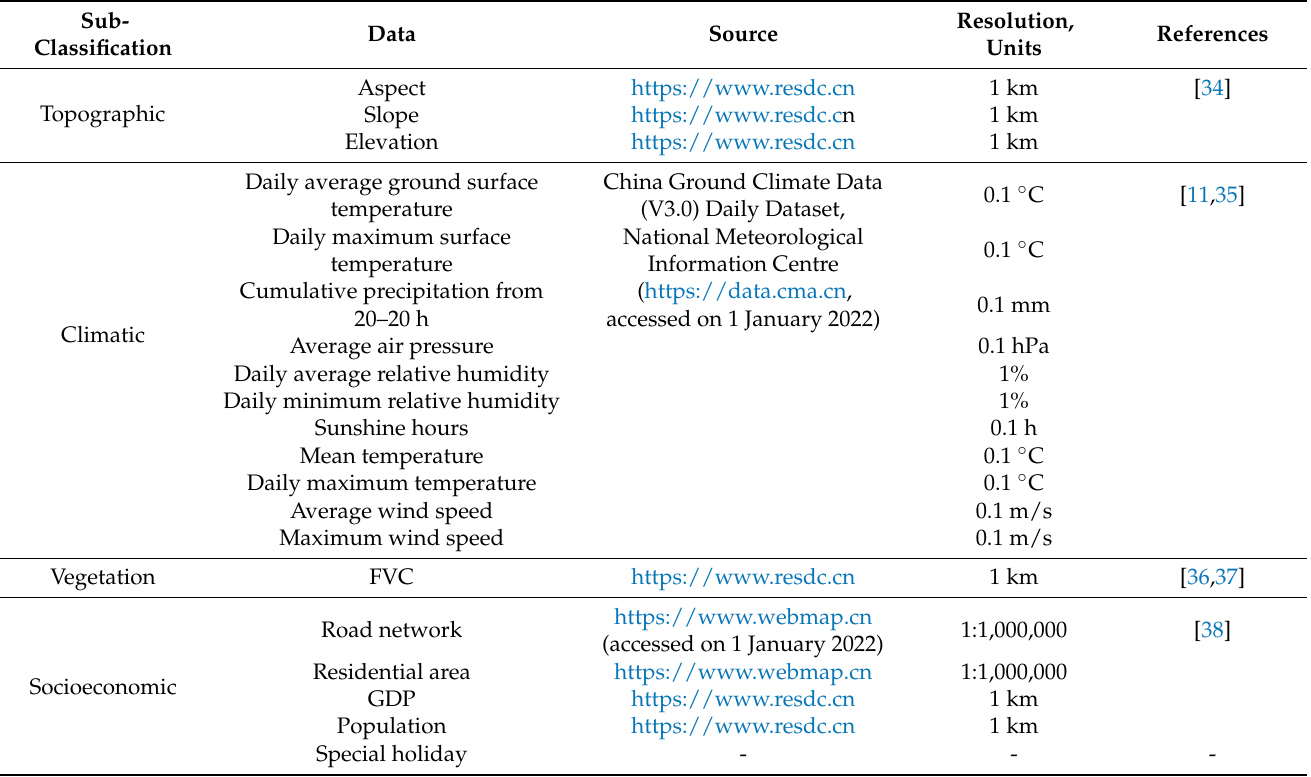
Table 1. Description of datasets used in the present